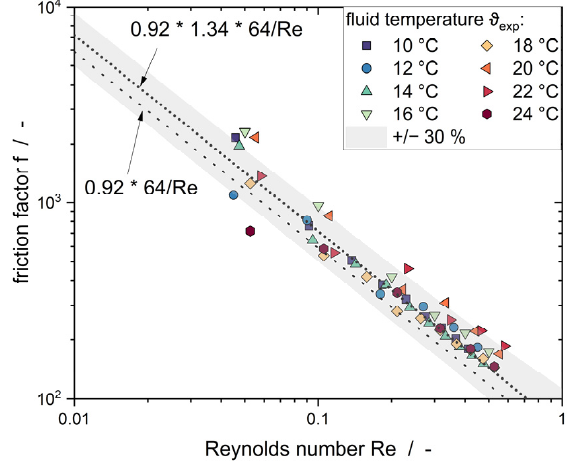
Figure 7. The so-called Moody diagram shows the friction factor f as a function of the Reynolds number Re . The friction factor was calculated according to Equation (1), Re according to Equation (2). The grey region represents the range of ± 30% of the fitted data points ( f = 0.92 · 1.34 · 64/ Re ). 0.92 hereby represents the correction factor for using a rectangular channel instead of a round cross- section [15]. The additional correction factor of 1.34 is a result of the roughness of the channel walls. When the temperature was increased, the pressure drop through the channel decreased at all velocities of the continuous phase. There is a good agreement between the